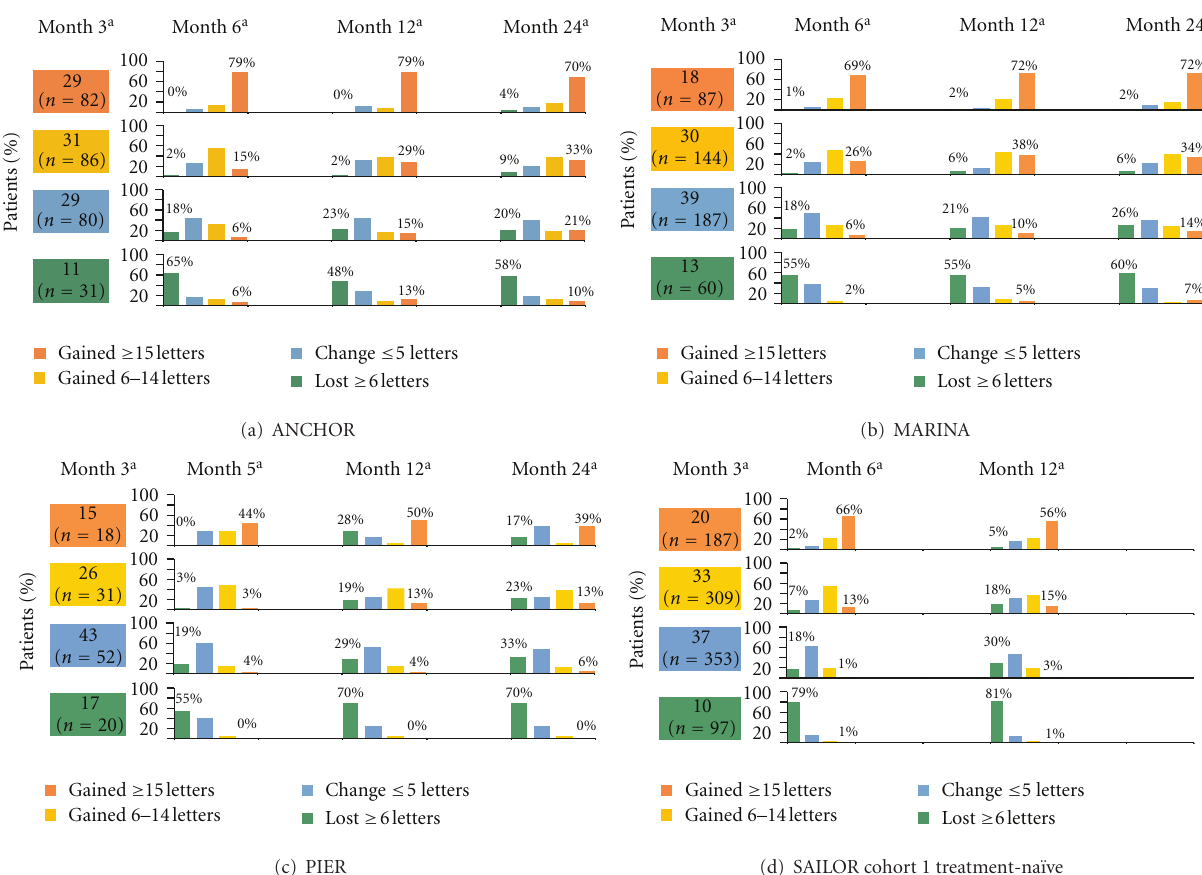
Figure 2: Distribution of visual acuity change from baseline based on visual acuity status at month 3 among pooled ranibizumab-treated patients by clinical trial. a All visual acuity changes are compared with baseline. For ease of interpretation, all percentages are rounded to the nearest whole